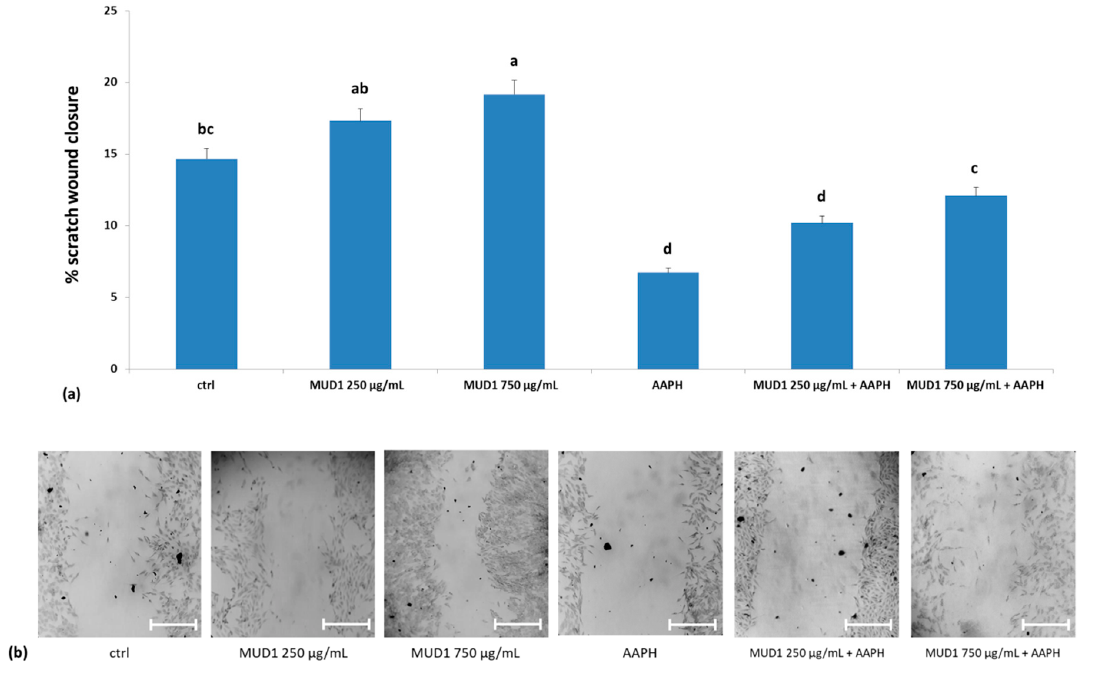
Figure 7. Scratch wound closure ( a ) in HDF cells treated with different concentrations of MUD1 (250–750 µg/mL) for 24 h or AAPH (10 mM) for 24 h and with different concentrations of MUD1 and then with AAPH. Data are expressed as mean values ± SD. Columns with different superscript letters are significantly different ( p < 0.05). Representative images illustrating the migration of HDF cells into the scratch wound during different treatments exposure ( b ). Scale bars = 100 µm